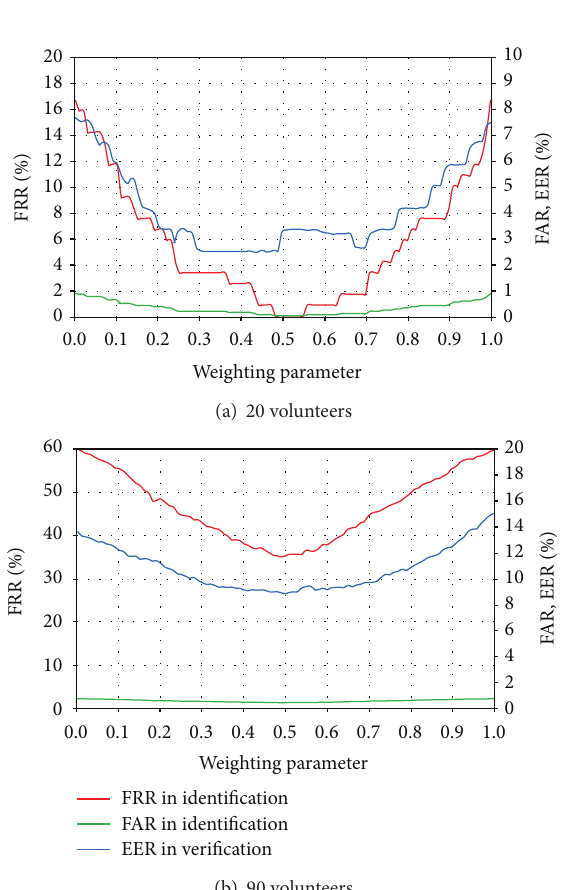
Figure 15: Authentication performances on weighting sum opera-